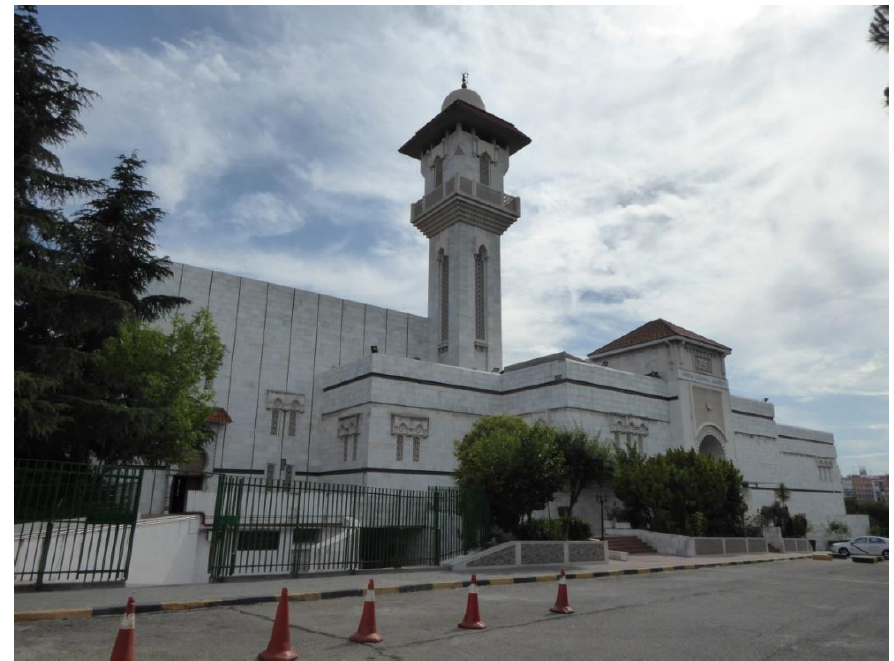
Figure 8. Façade of the Omar Mosque and Islamic Cultural Centre (1977). Madrid. Photo took by author.